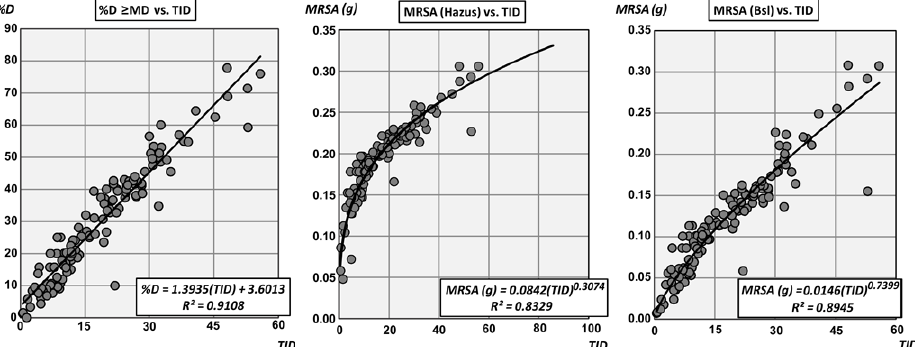
Fig. 6. Regression equations relating the total damage index (TID) with the percentage of buildings presenting moderate or larger degree of damage (% D ≥ MD) and MRSA (period ∼ 0.3s) estimated from the HAZUS and Bsl fragility curves per square area of the grid defined for Saint Nicolas.